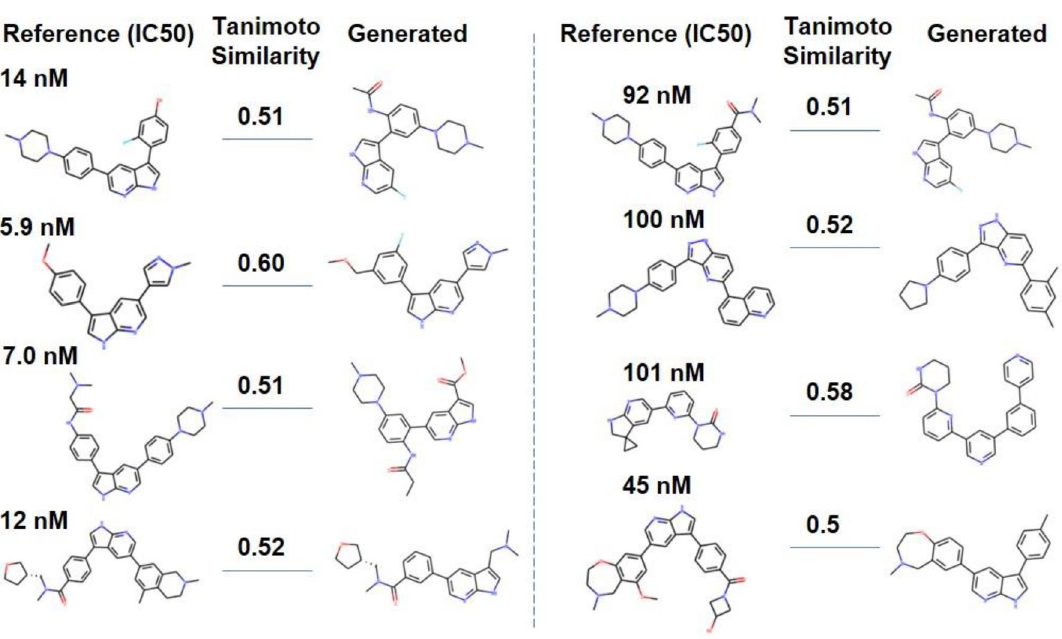
Figure 4. Examples of generated molecules that are similar to reference compounds for HPK1.